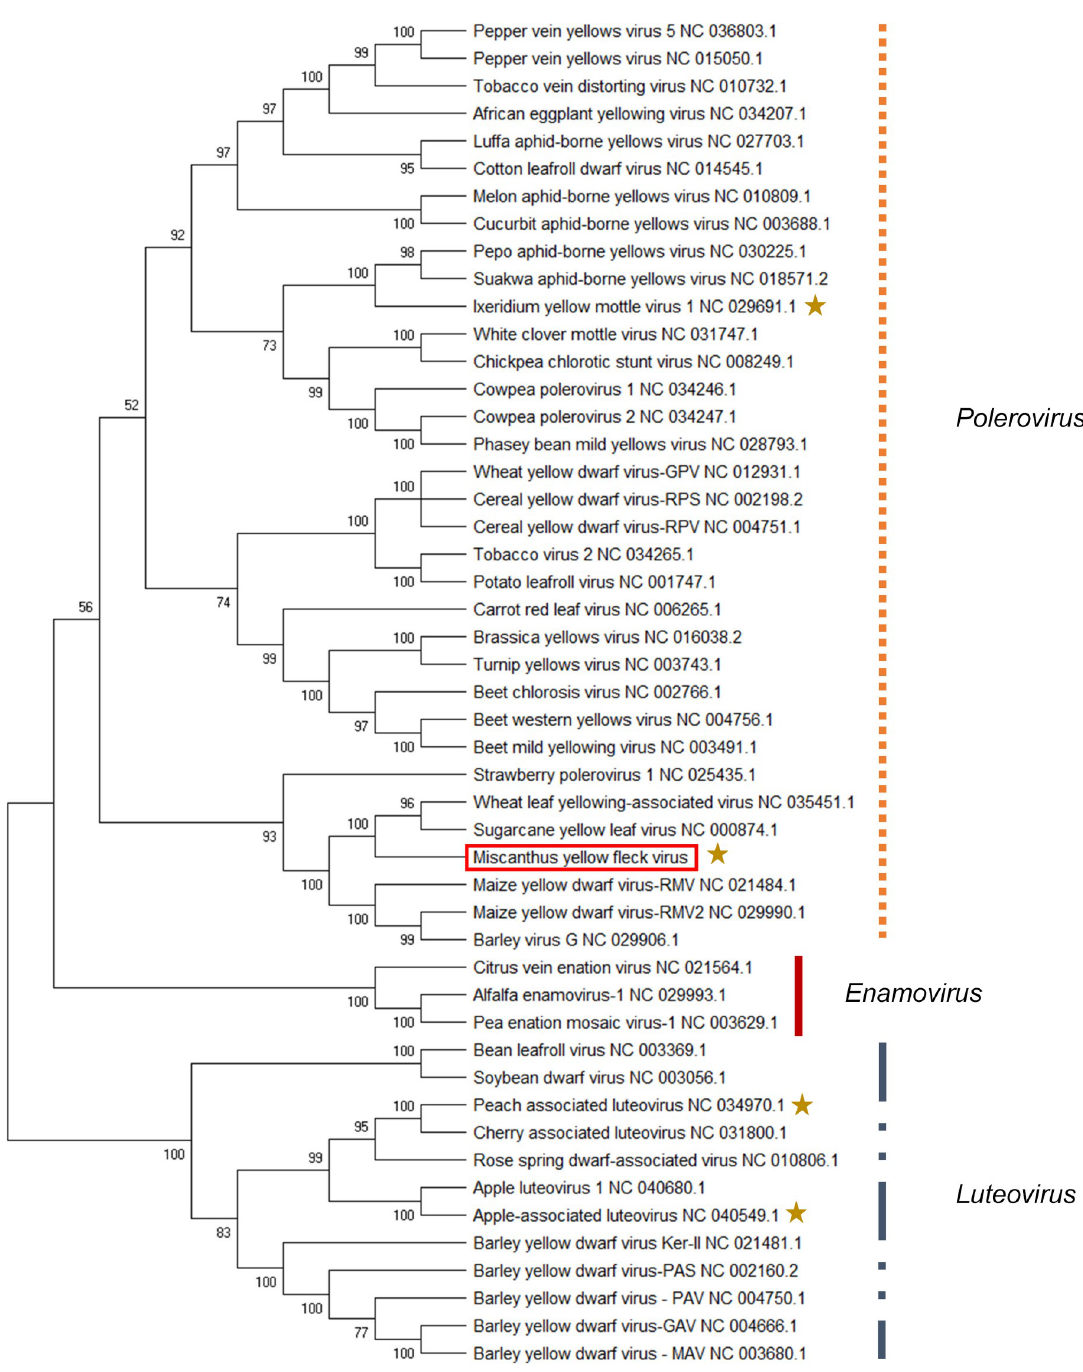
Fig 3. Phylogenetic tree showing the relationship of the complete genome of Miscanthus yellow fleck virus to viruses within the family Luteoviridae . Virus names are shown alongside their corresponding NCBI accession numbers. ClustalW was used to align Miscanthus yellow fleck virus with 48 complete viral genome sequences, and there were 7803 positions in the final dataset. The phylogenetic tree was constructed using the Maximum Likelihood method and Tamura-Nei model with MEGA-X software [17]. The numbers next to branches indicate the percentage of 1000 replicate trees in which associated taxa clustered together. Branches with less than 50% bootstrap support were collapsed. � unclassified Luteoviridae virus.